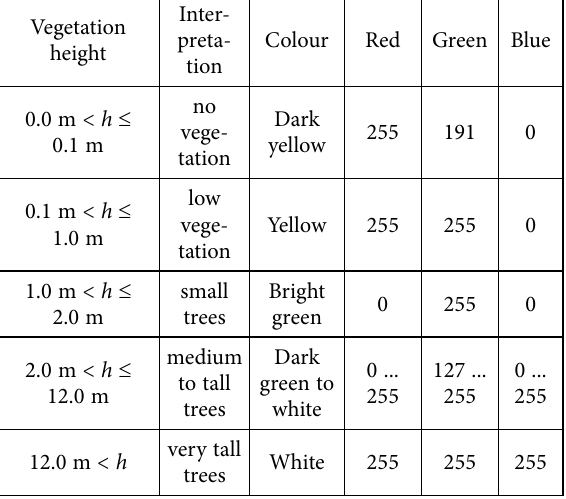
Table 3. Colour codes for vegetation height in base maps Vege tation